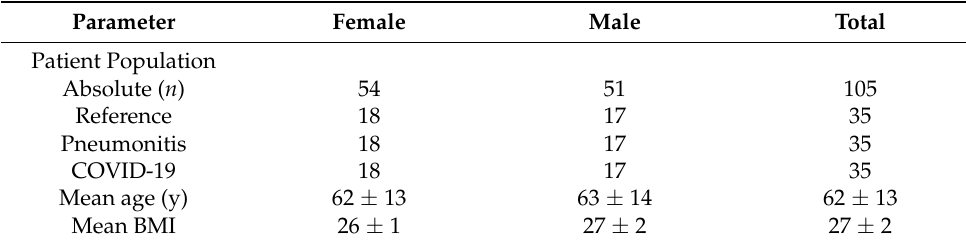
Figure 1. Patient inclusion and study workflow. Table 1. Patient characteristics.